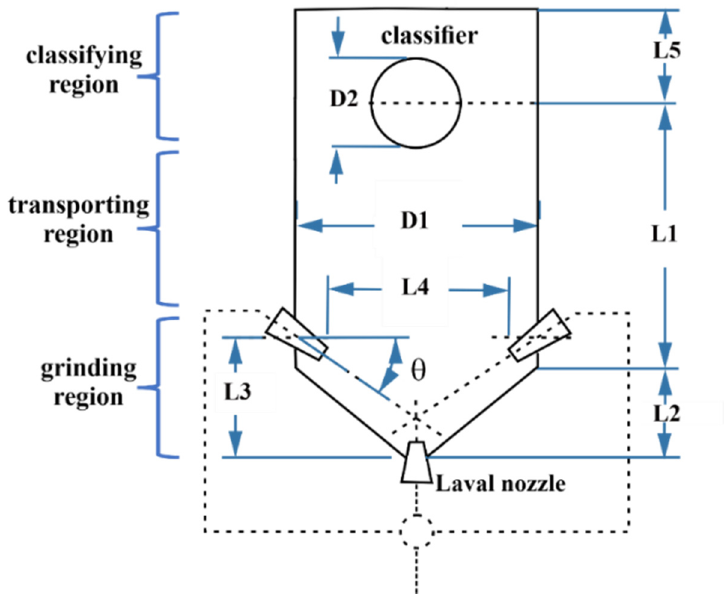
Figure 1. Scheme of the fluidized bed opposed gas jet mill considered in the numerical studies. Table 1. Geometric parameters of the fluidized bed opposed jet mill unit according to Figure 1. Parameter Value